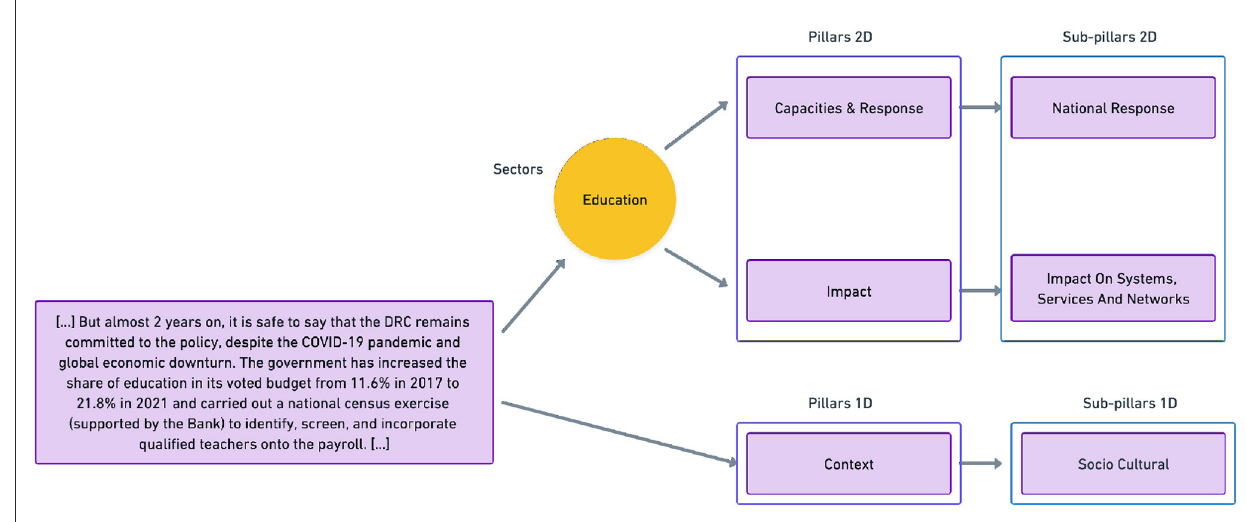
FIGURE4 Example of text excerpt from HUMSET annotated through its multidimensional and hierarchical ontology (Fekih et al.,